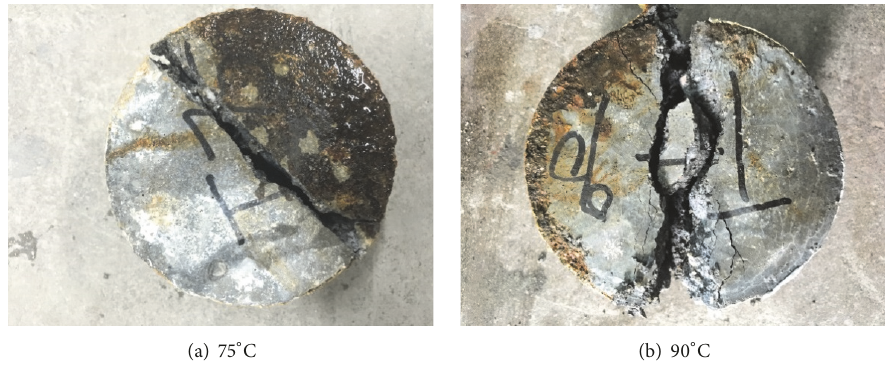
Figure 6: Concrete morphology after chloride ion penetration.